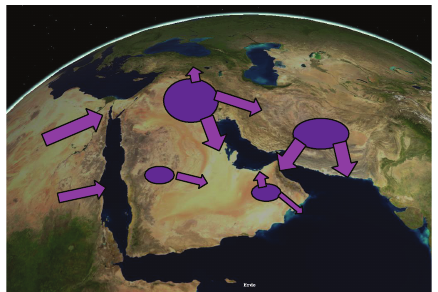
Figure 1: Dust sources surrounding the Arabian Peninsula.